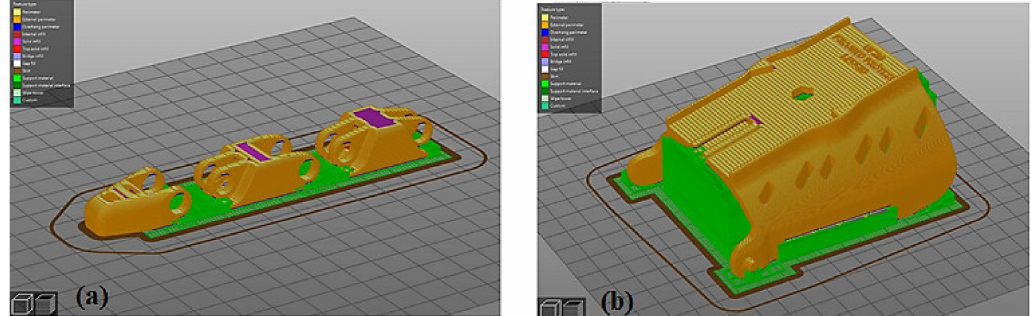
Figure 18. Software-generated images for initiating the three-dimensional printing process: ( a ) index finger phalanges and ( b ) wrist support.